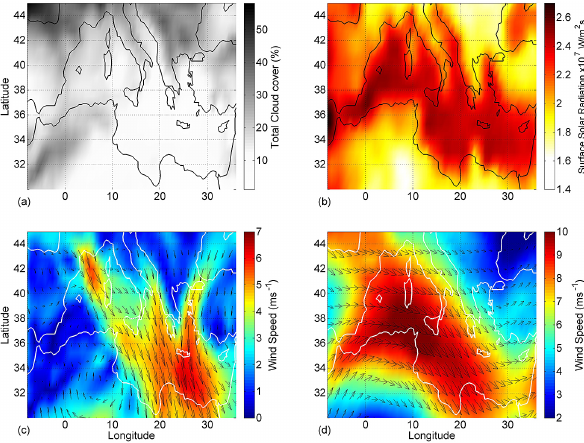
Figure 1. An example of the ECMWF (European Centre for Medium-Range Weather Forecasts) Reanalysis (ERA-Interim) for the period June-July-August (JJA) 2010 for (a) total cloud coverage, (b) 12:00UTC solar radiation reaching the surface, (c) wind speed and direction averaged from the surface to 750hPa, and (d) wind speed and direction averaged from 750 to